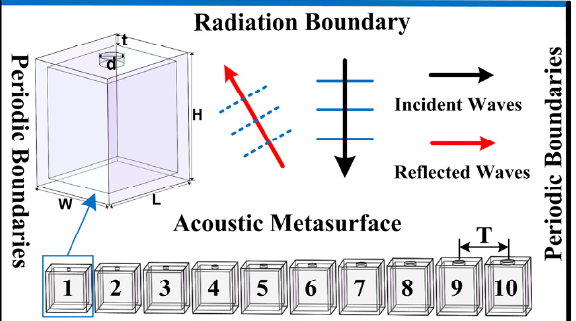
Figure 1. Cross section view of the acoustic metasurface (AMS) with a periodic boundary condition in the simulation environment.